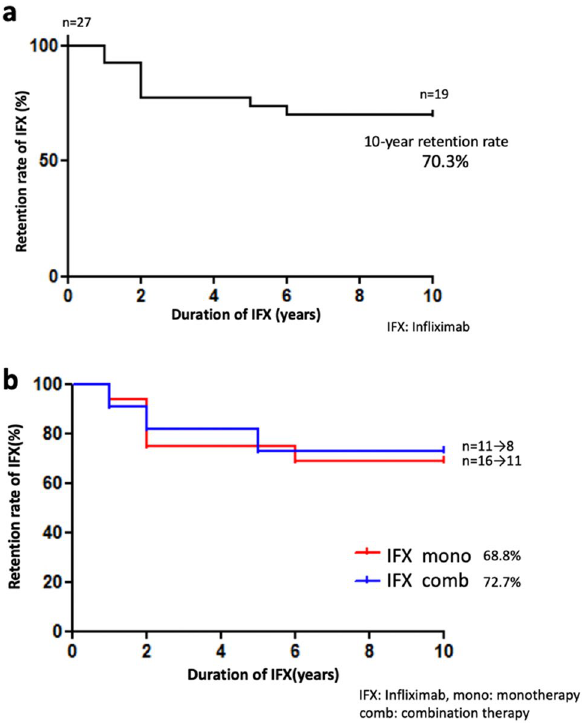
Figure 1. Retention rate of IFX therapies. ( a ) The overall 10-year retention rate of IFX therapy in patients was 70.3%. ( b ) The 10-year retention rate of IFX monotherapy was 68.8%, whereas that for the combination therapy was 72.7%. There was no significant difference between the monotherapy and combination therapy (p =